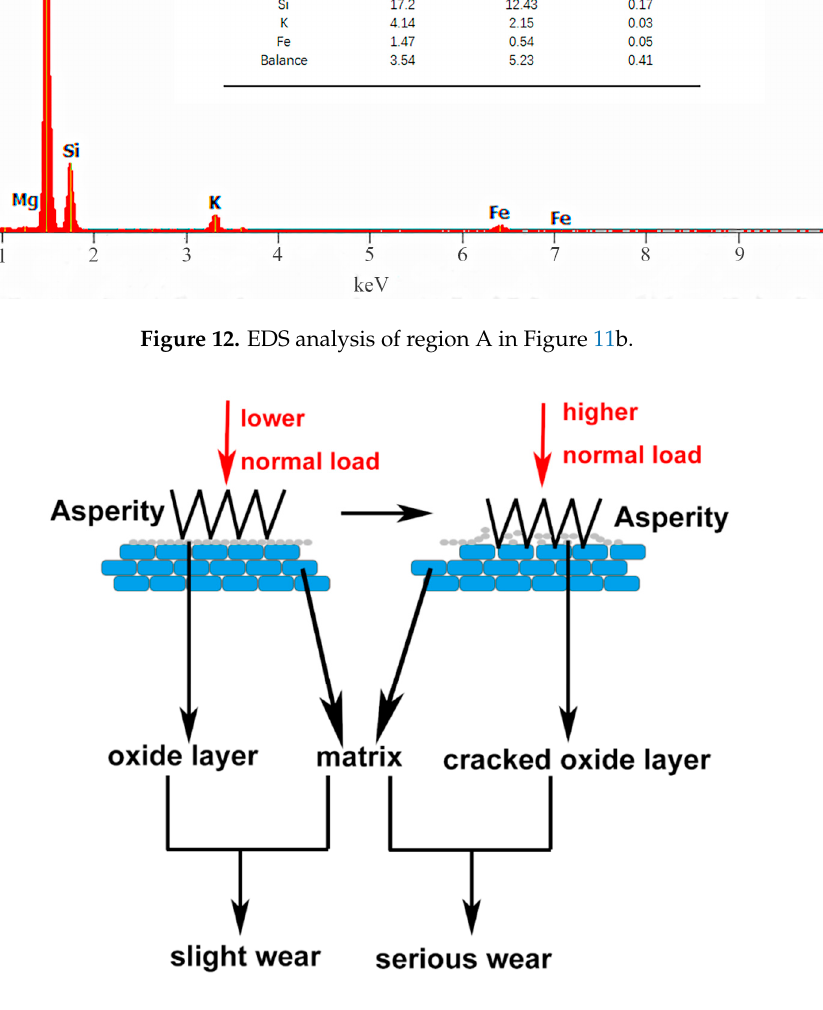
Figure 13. Schematic diagram showing the wear in low normal load and high normal load.